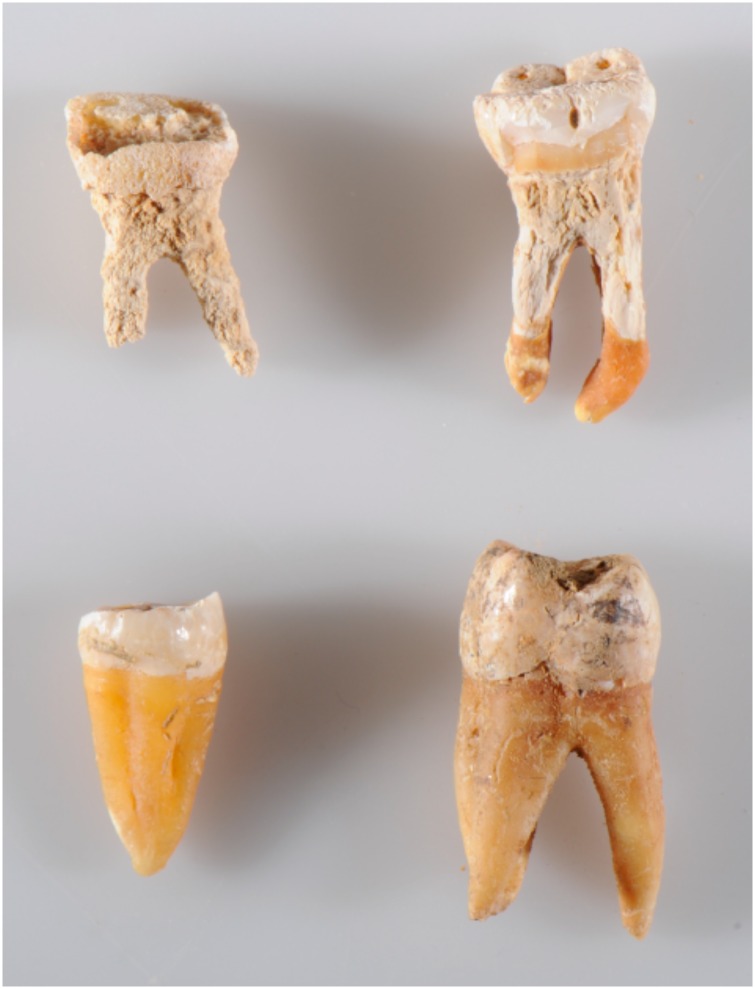
Visual tooth preservation.Examples of poor and good tooth preservation as recorded from simple visual inspection during the sample processing. The upper (poor preservation) teeth display a root with a brittle and "chalky" appearance and the cementum layer is either fragmentary or completely gone. This in contrast to a thick, hard and compact cementum layer observed in the two lower teeth (good preservation).